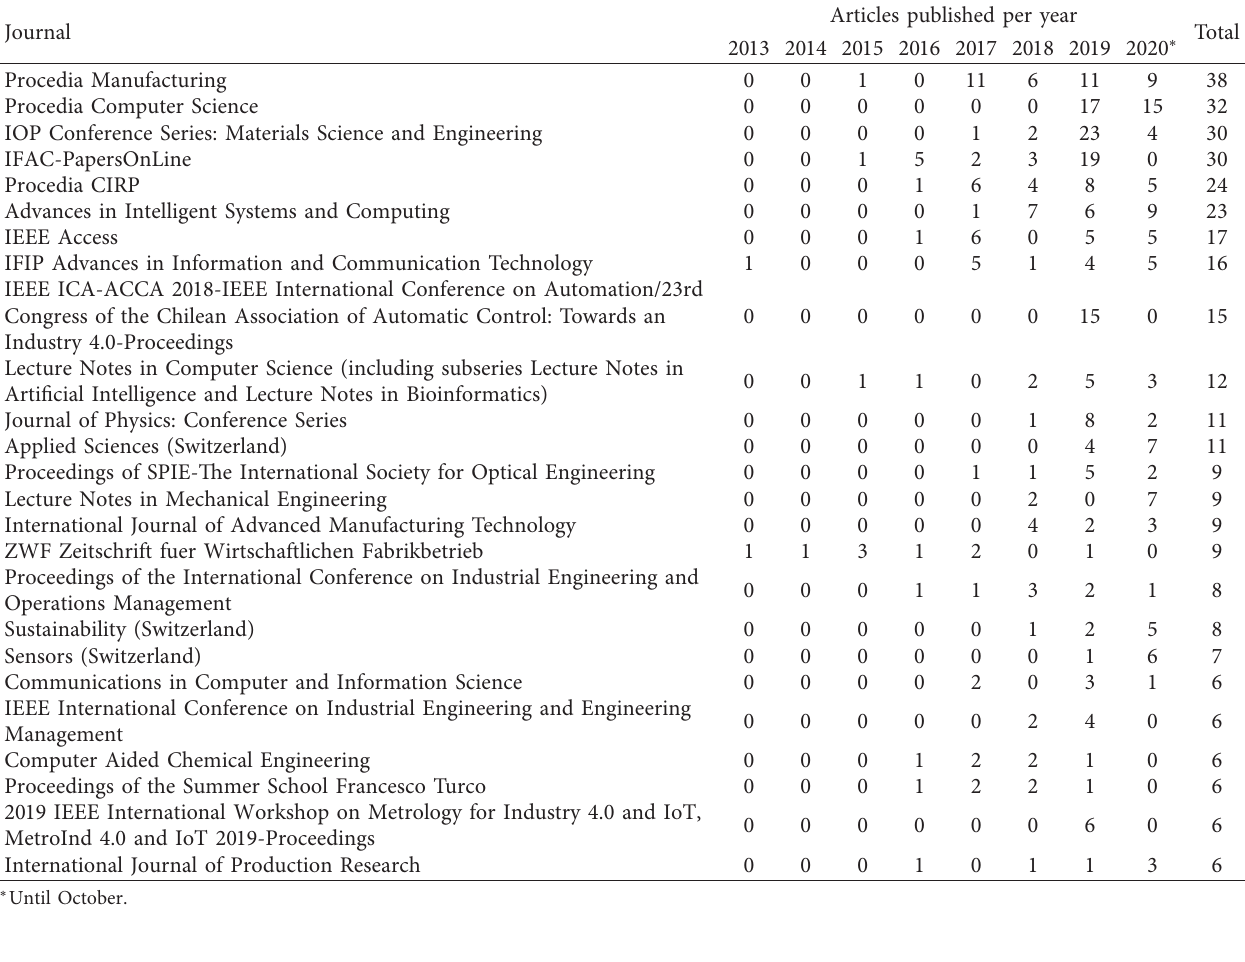
Table 3: Articles by journal and period. The 25 most frequently publishing journals can be considered as well as the number of published papers each